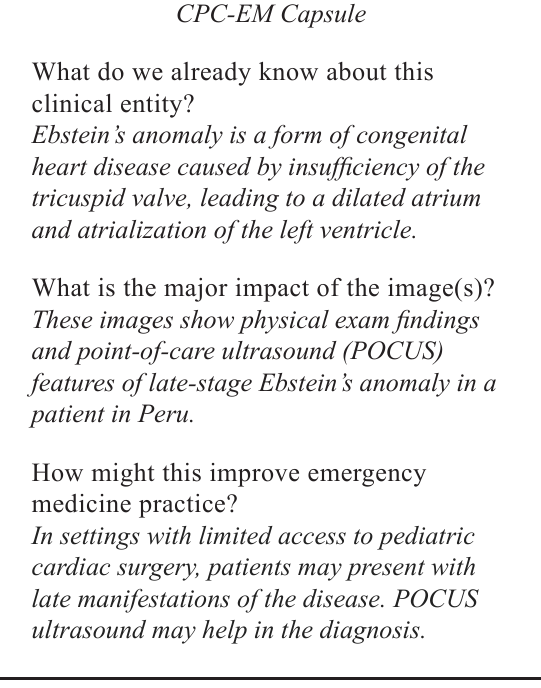
Documented patient informed consent and/or Institutional Review Board approval has been obtained and filed for publication of this case